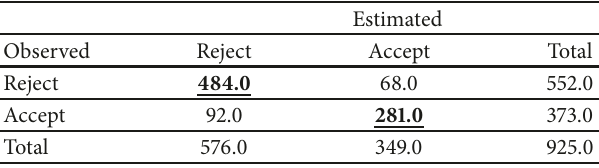
Figure 3: Box plot of the reverse succession of offered gaps. Table 7: Comparison of estimated and observed values of logistic regression model.